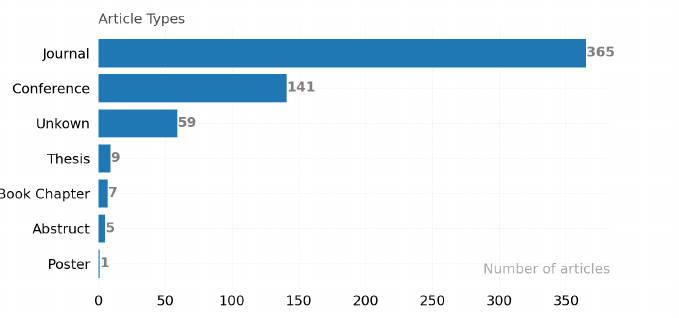
Figure 2. Distribution of article